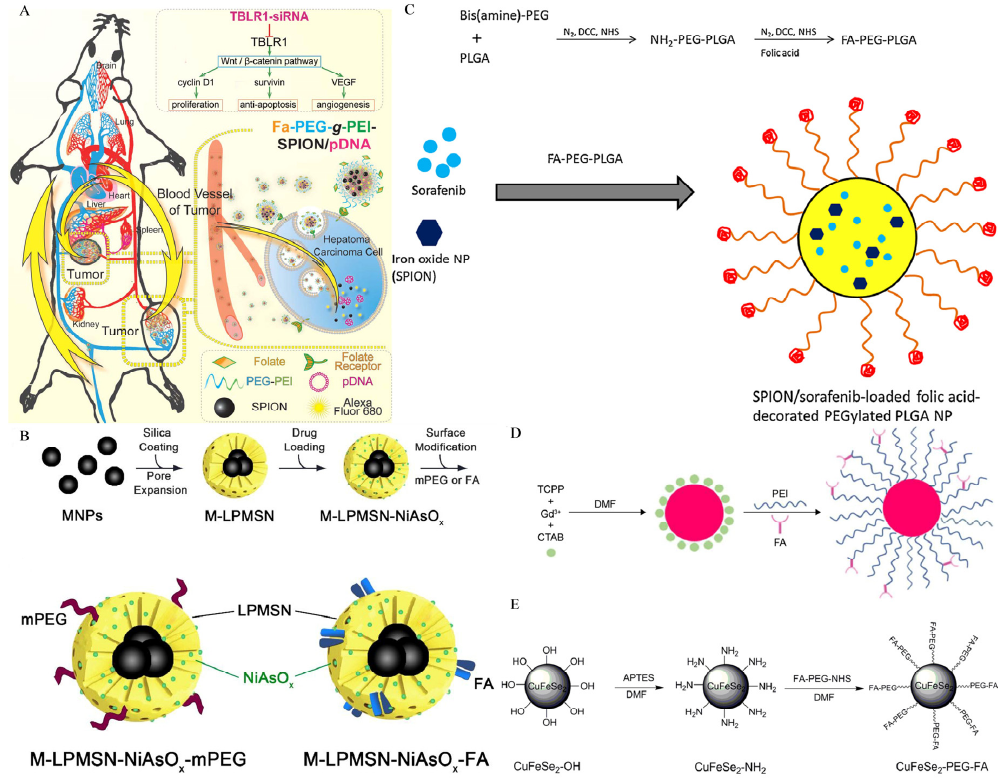
Figure 8. Different types of molecular imaging probes targeting folate receptors. ( A ) A schematic diagram of tumor-specific uptake and in vivo distribution of nanocomplexes carrying siRNA